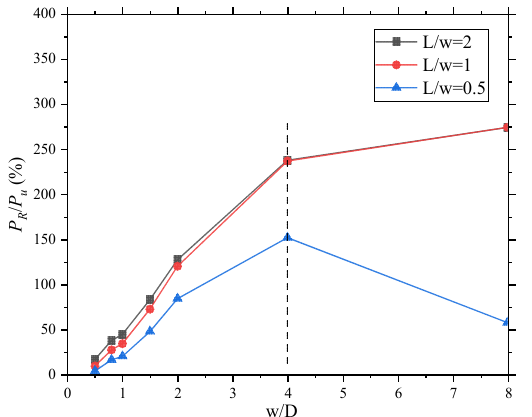
Figure 21. Repairing effect of CFRP on defects of different lengths.